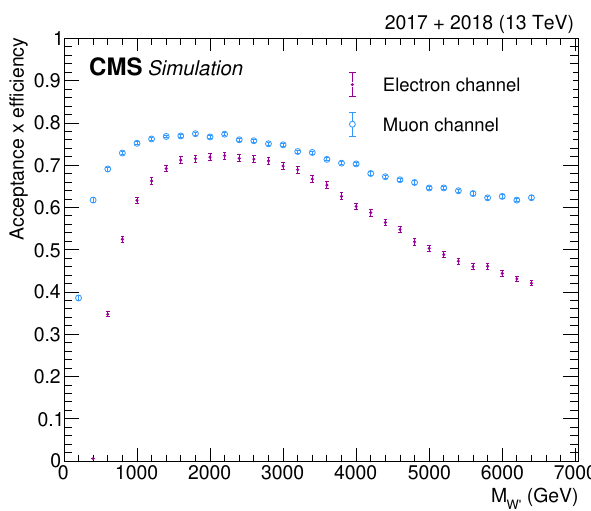
Figure 2 . Product of acceptance and efficiency for the SSM W 0 signal, as a function of the W 0 mass, after all selection criteria are applied for the electron (filled purple markers) and the muon (open blue markers)